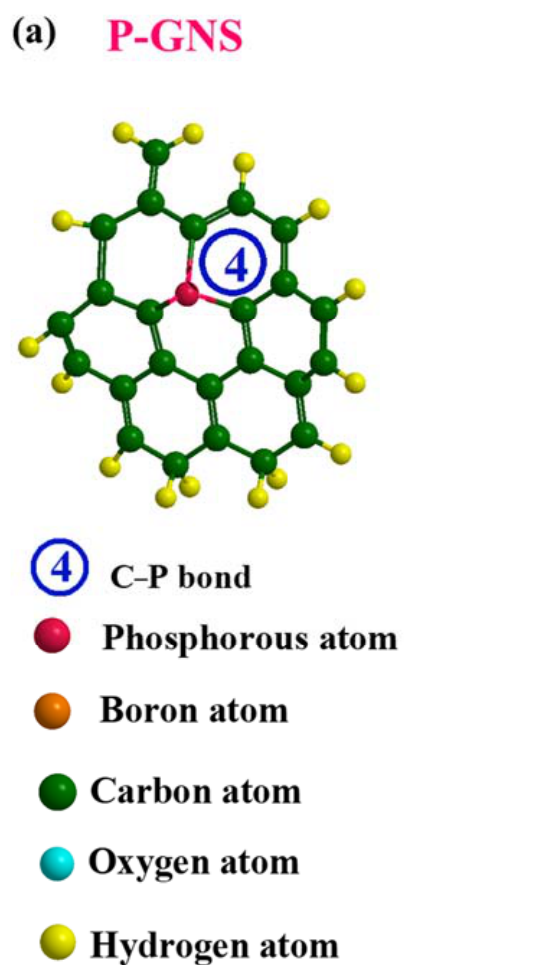
Figure 2. Structure of ( a ) P-GNS and ( b ) B-GNS.